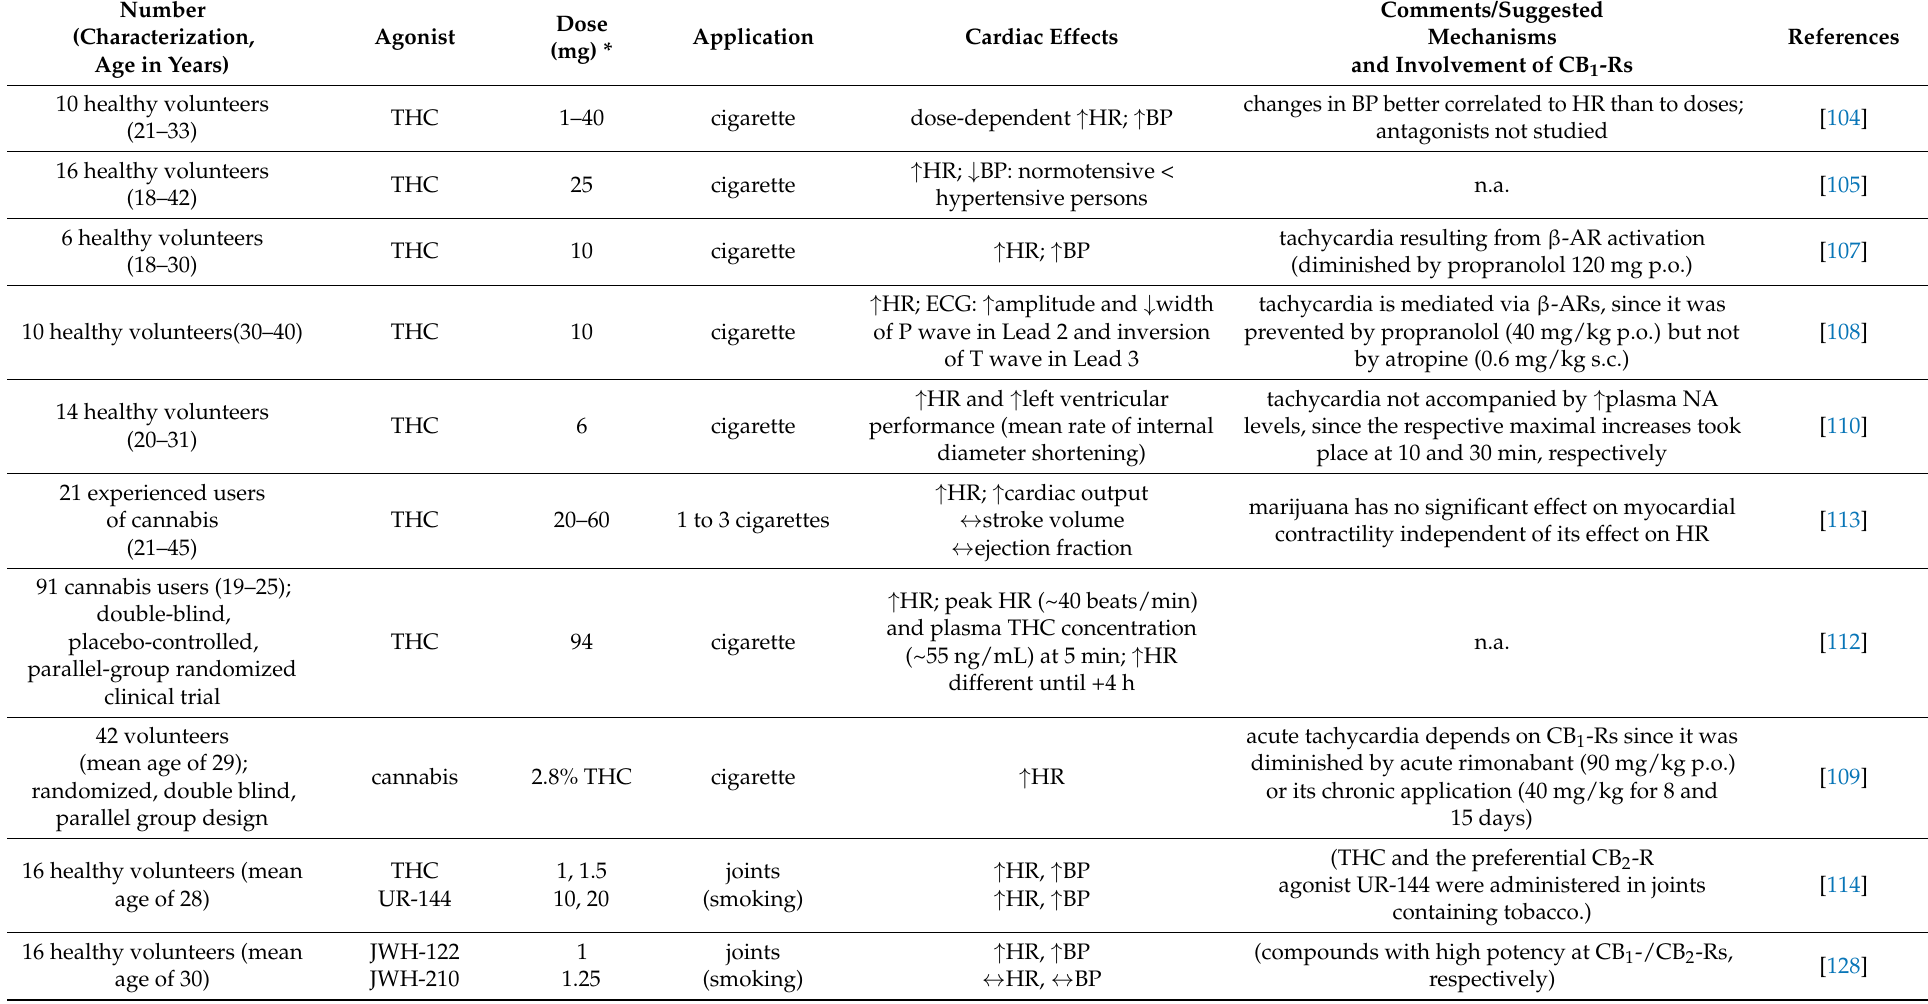
Table 2. Cardiac effects of acute cannabinoid administration in